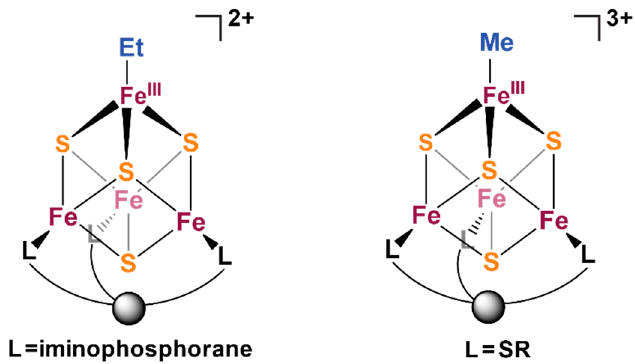
Figure 5. Fe 4 S 4 -alkyl clusters stabilized by chelating tripodal ligand scaffolds recently reported by Suess et al.